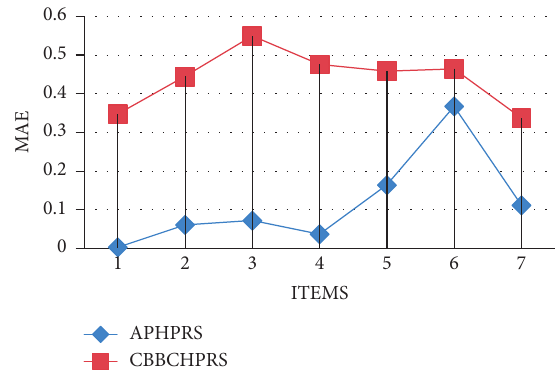
Figure 3: MAE for the two recommender systems for dataset